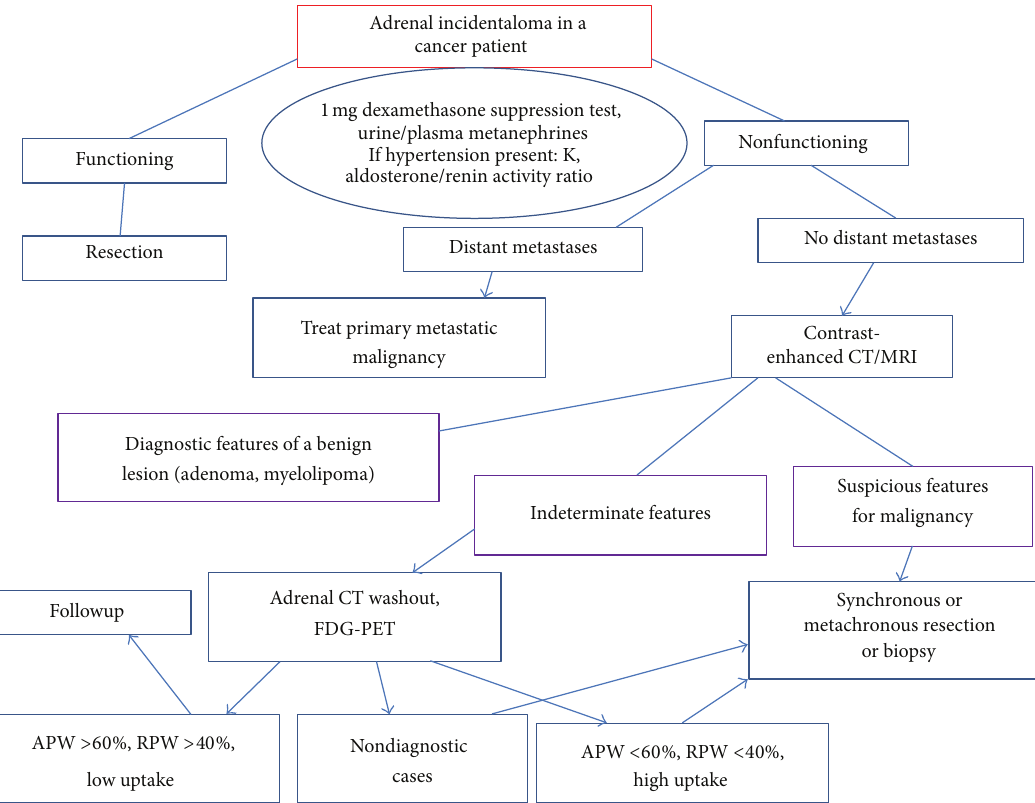
Figure 4: Proposed algorithm for the management of cancer patients with adrenal incidentaloma. An adrenal CT washout is a triphasic adrenal CT used for determining whether an adrenal lesion is an adenoma. It is based on the fact that adenomas (regardless of lipid content) show pathognomonic rapid enhancement and corresponding rapid washout following contrast medium administration. CT: Computed Tomography, MRI: Magnetic Resonance Imaging, RPW: Relative Percentage Washout, APW: Absolute Percentage Washout, PET: Positron Emission